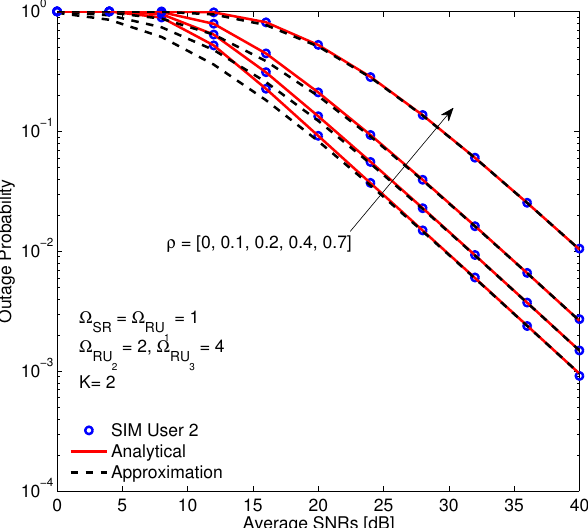
Figure 7. The OP versus average SNR with different correlation coefficients and α = 0.3, η = 0.85, a 1 = 0.6, a 2 = 0.3, a 3 =